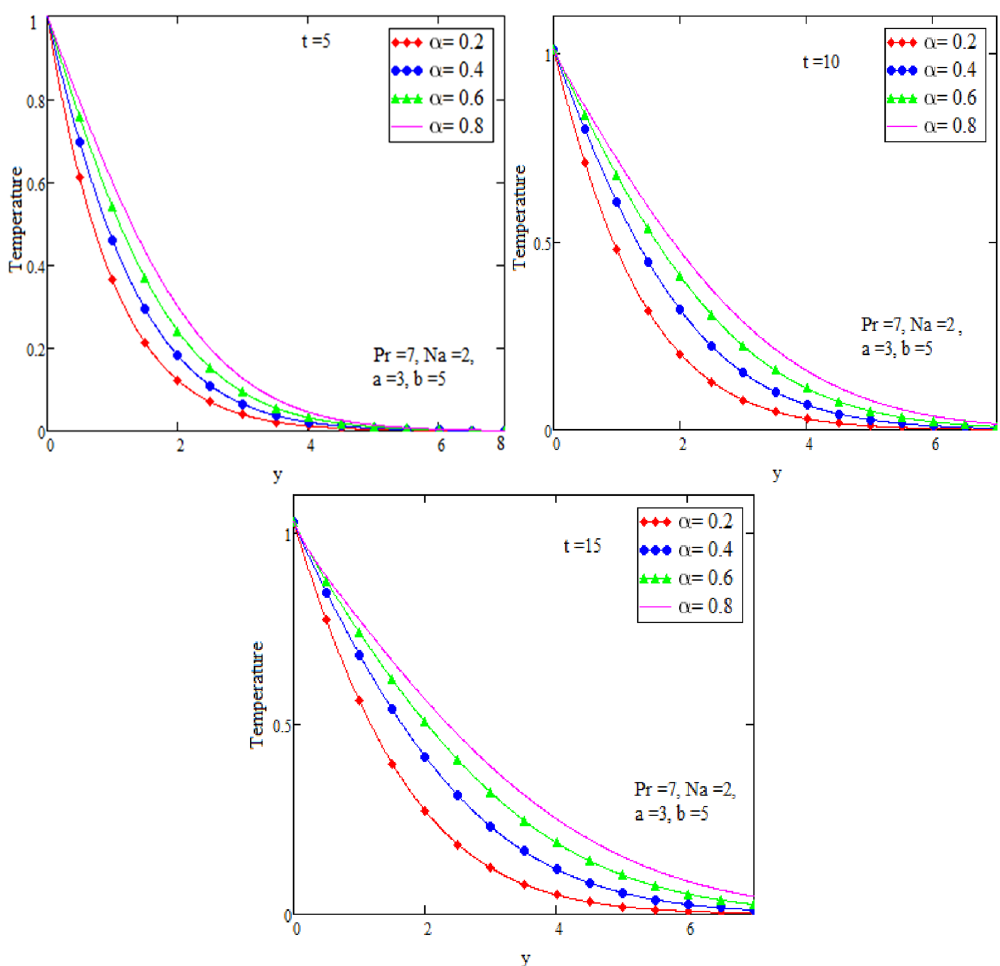
Figure 2. Graph of temperature for different value of alpha